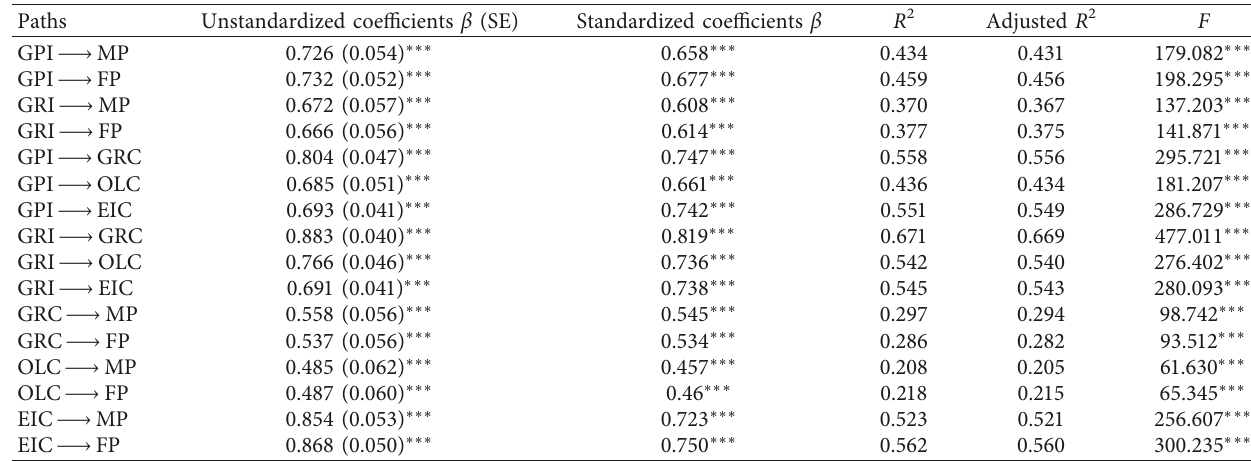
Table 11: Empirical results of regression analysis.